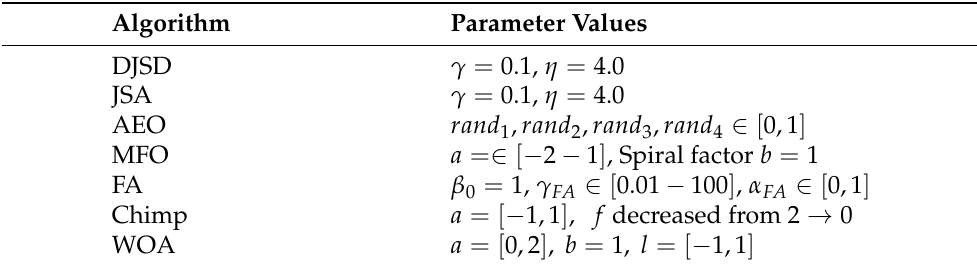
Table 1. The value of each parameter of compared methods.